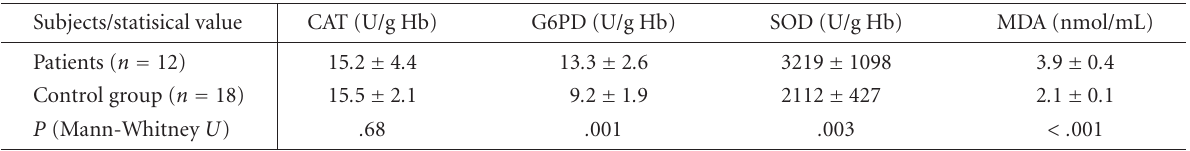
Table 2. The mean values of catalase (CAT), glucose-6-phosphate dehydrogenase (G6PD), and superoxide dismutase (SOD) activities and malondialdehyde (MDA) levels in pediatric subgroups in both groups (mean ± standard deviation). Subjects/statisical value